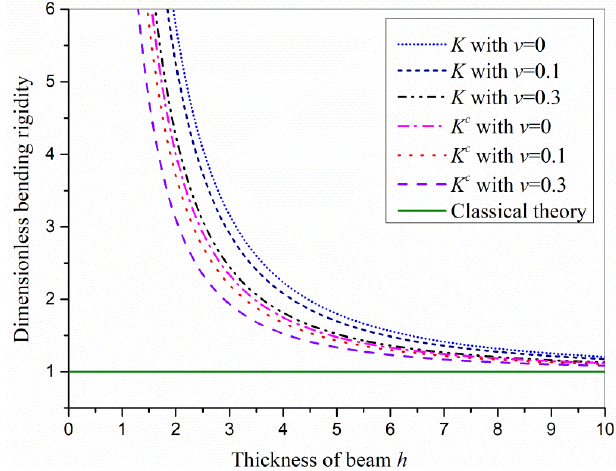
Figure 1. Size effect of plane ‐ strain beams.